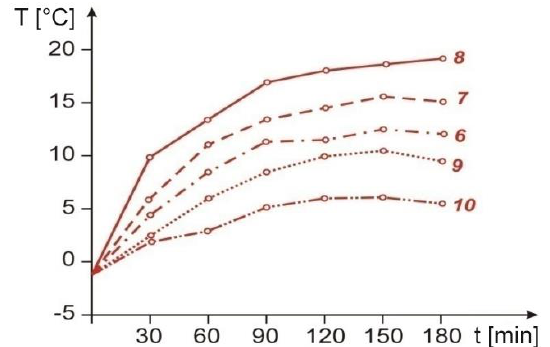
Figure 8. Temperature on the rail web [14].